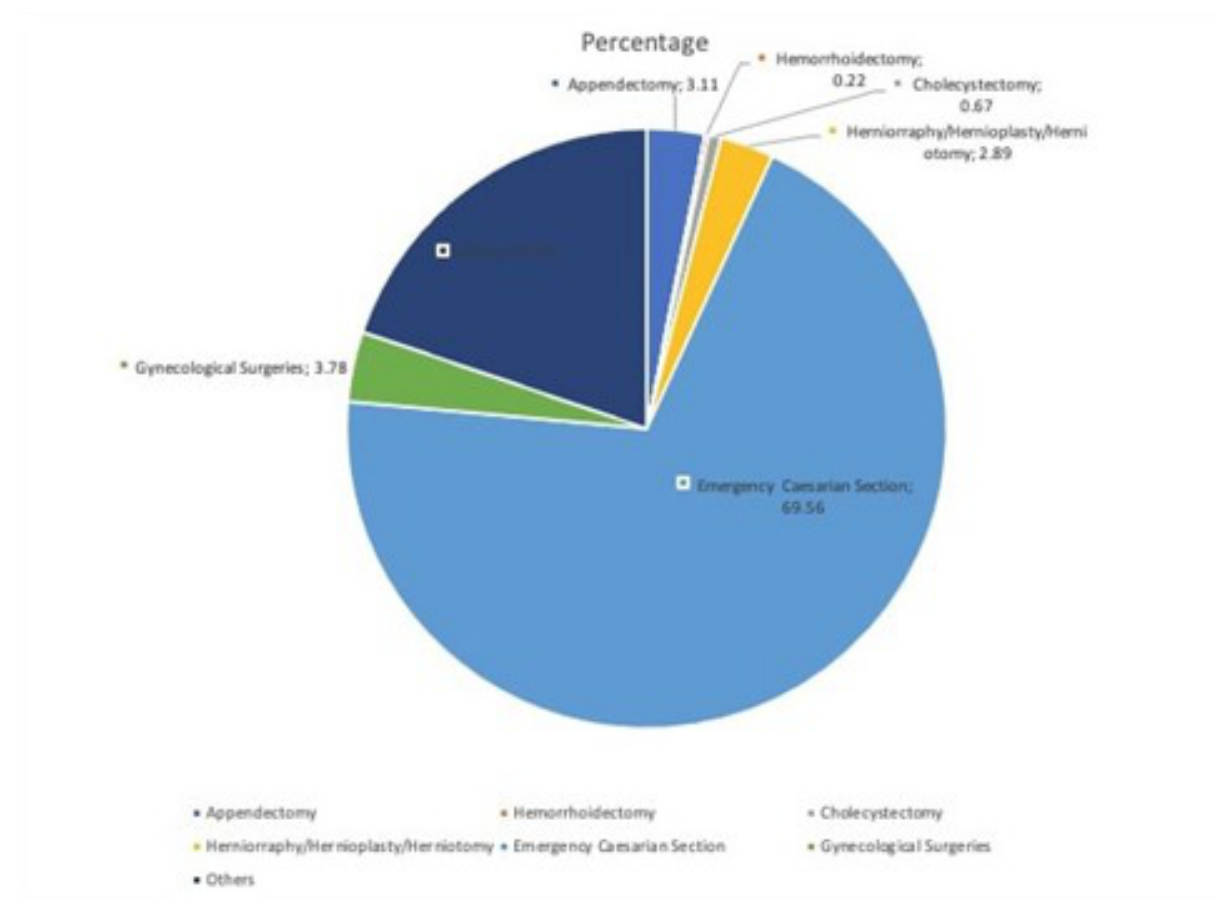
Fig 2. Indications for surgery. Others: Lumpectomy, Orchidectomy, Lipomas, Splenectomy, Hydrocelectomy, Fistulectomy, Cystectomy.